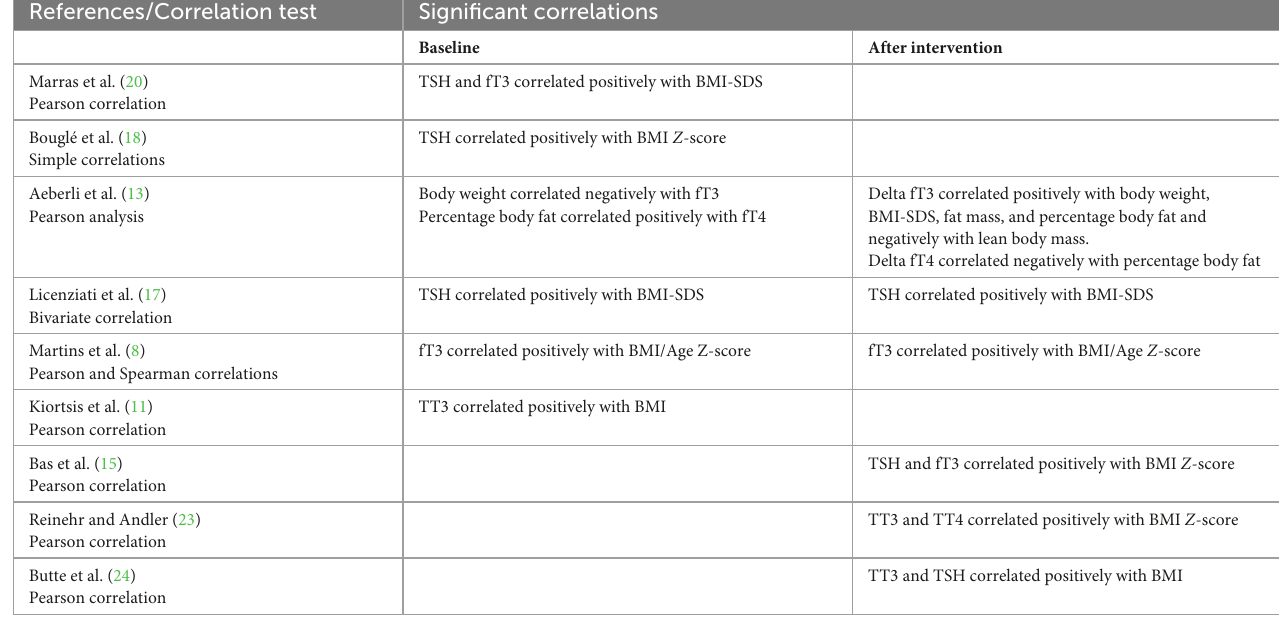
TABLE 1 Correlations between anthropometric recovery and hormonal